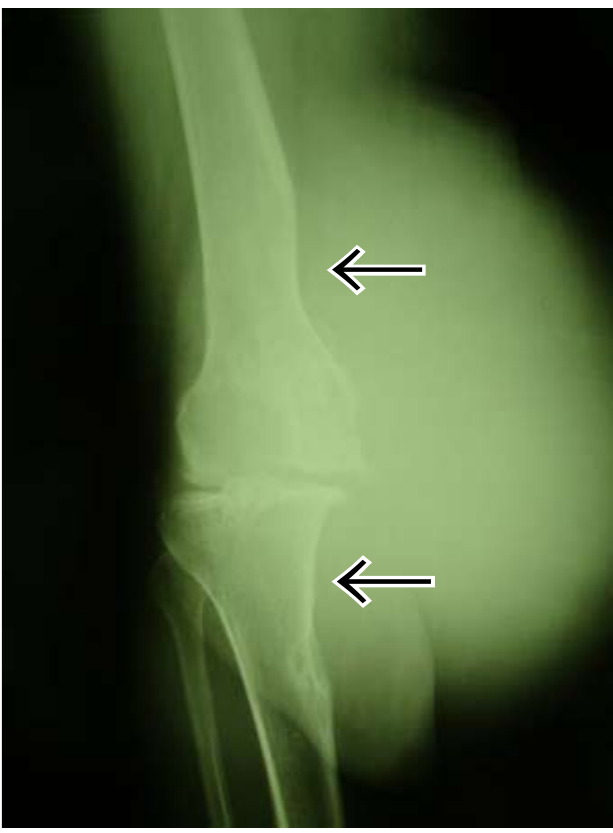
Fig. 16c. Anteroposterior X-ray of the knee with soft-tissue neurofibroma of the knee with extensive pressure changes.